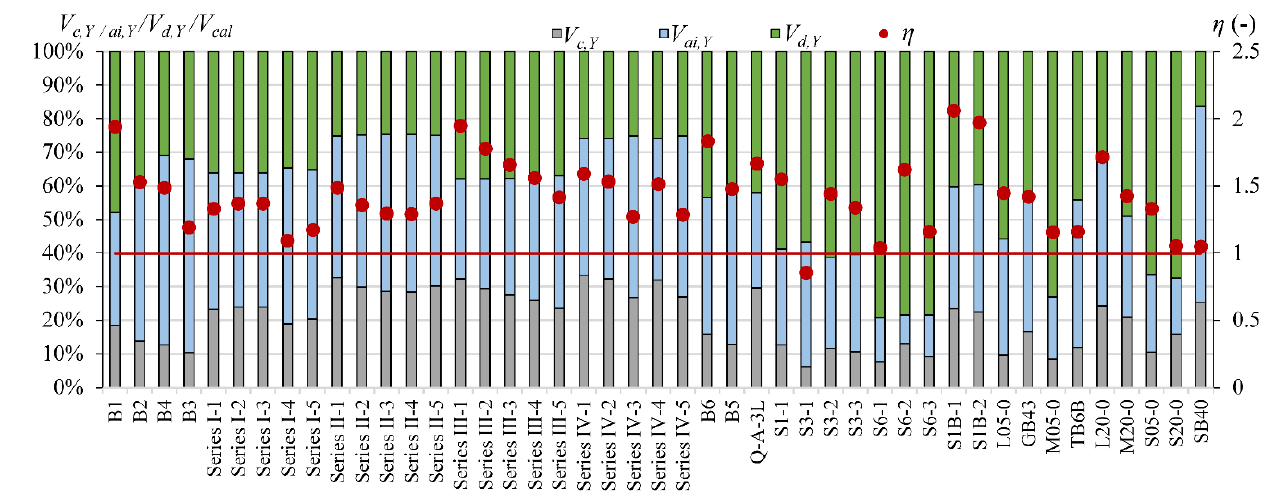
Figure 6. The comparison of shear mechanism contribution according to Yang’s model for rectangular beams (red line indicated η = 1).